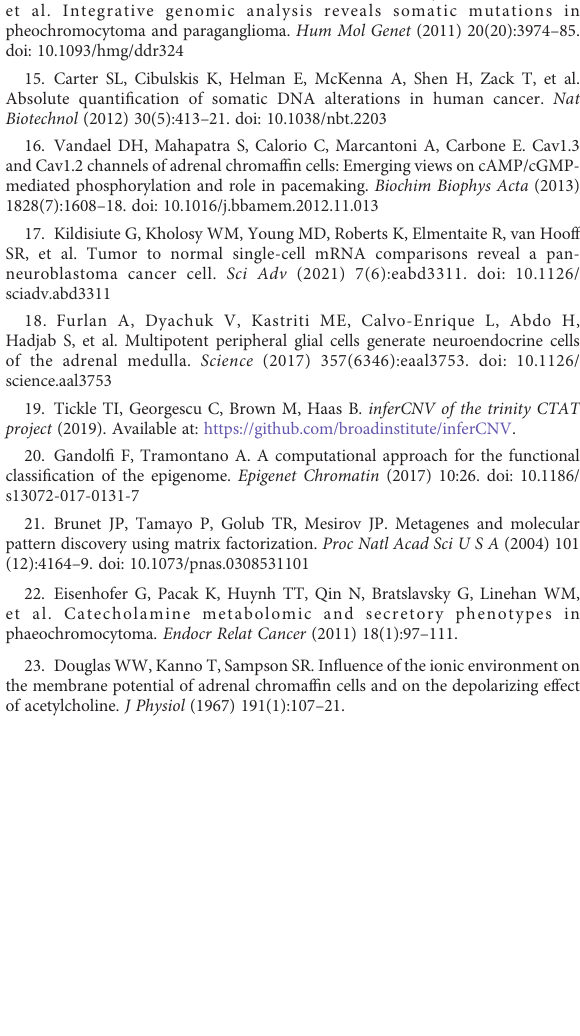
as macrophages, found in tumors from similar anatomical locations. (blue: from an SDHB-tumor, red: from a RET-tumor). (B) UMAP visualization and relative expression levels of canonical cell type markers across the PCPG immune cell subcluster. (C) UMAP visualization of the PCPG stromal cell sub-cluster after re-clustering (no batch-correction). (D) UMAP visualization and relative expression levels of canonical cell type markers across the PCPG stromal cell sub-cluster. SUPPLEMENTARY TABLE 1 Clinical information and snRNAseq quality parameters of processed/ analyzed